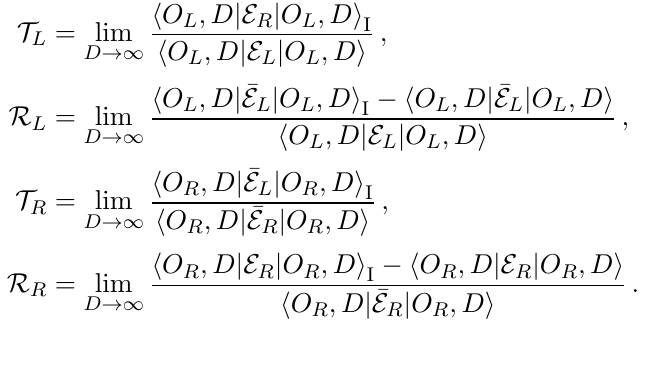
Table 1 . Relevant singularities in the three-point function h O L ( z 1 ; (cid:22) z 1 ) T (cid:22)(cid:23) ( z; (cid:22) z ) O L ( z 2 ; (cid:22) z 2 ) i (cid:12)xed ( z i ; (cid:22) z i ) with i = 1 ; 2. For each component of the stress tensor, we report the position of